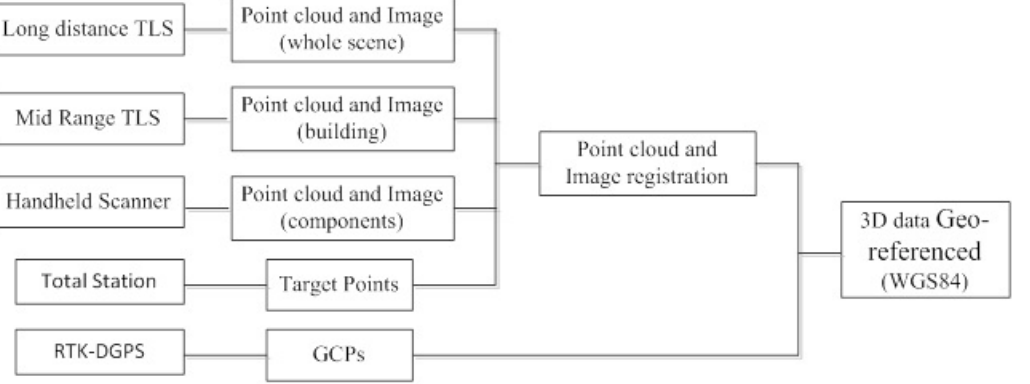
Figure 4. Workflow of field data collection.